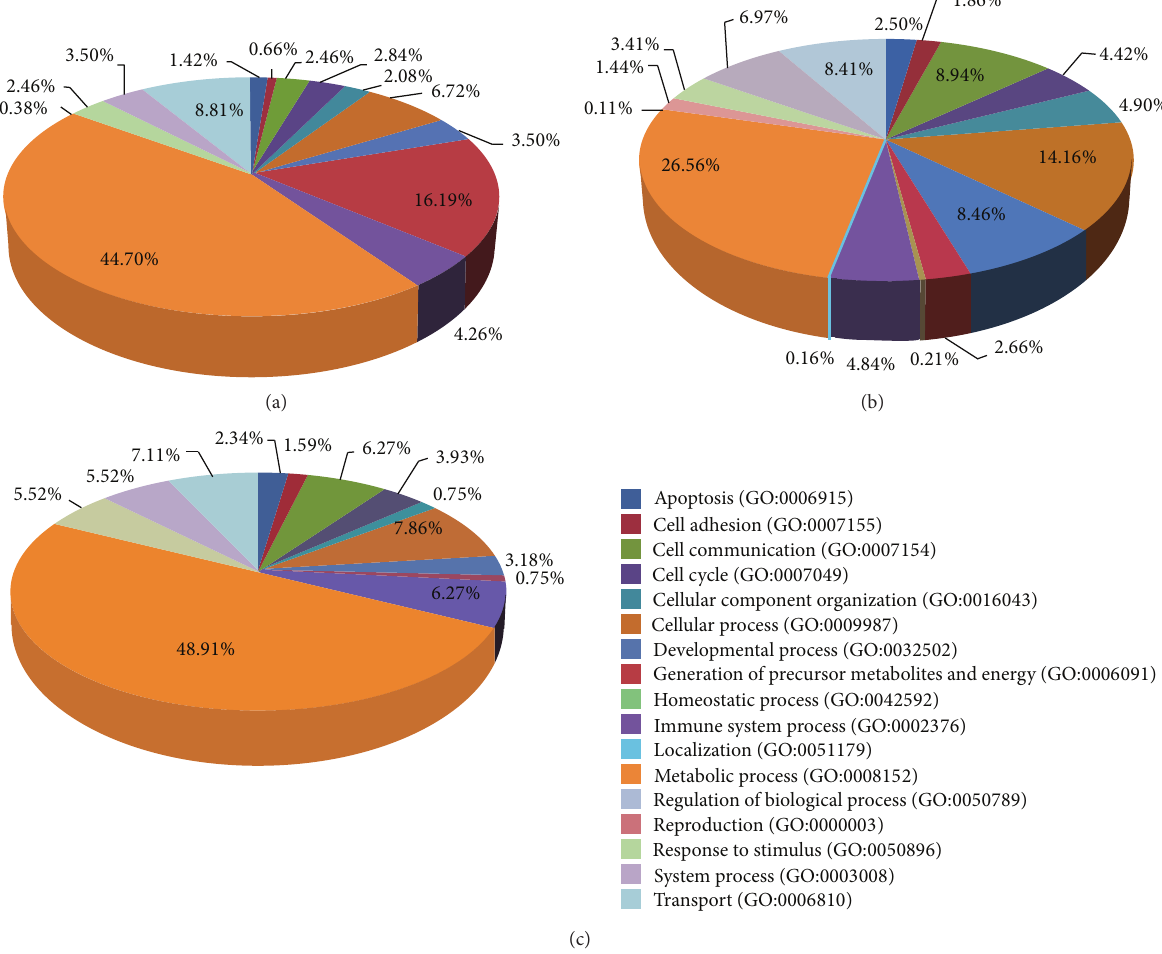
Figure 3: PANTHER analysis of the functional categories of genes coexpressed with MRCs. (a) Genes coexpressed in both normal tissues and chemically treated tissues. (b) Genes coexpressed with MRCs only in the tissue-based network. (c) Genes coexpressed with MRCs only in the chemically treated